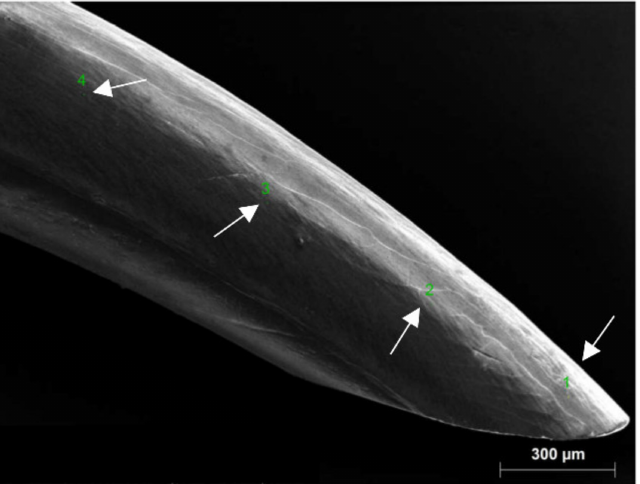
Figure 1. SEM image of spiny mouse incisor. Arrows indicate points in an approximate distance of 100 µ m, 500 µ m, 1000 µ m and 1500 µ m from the incisor tip at which the examination was